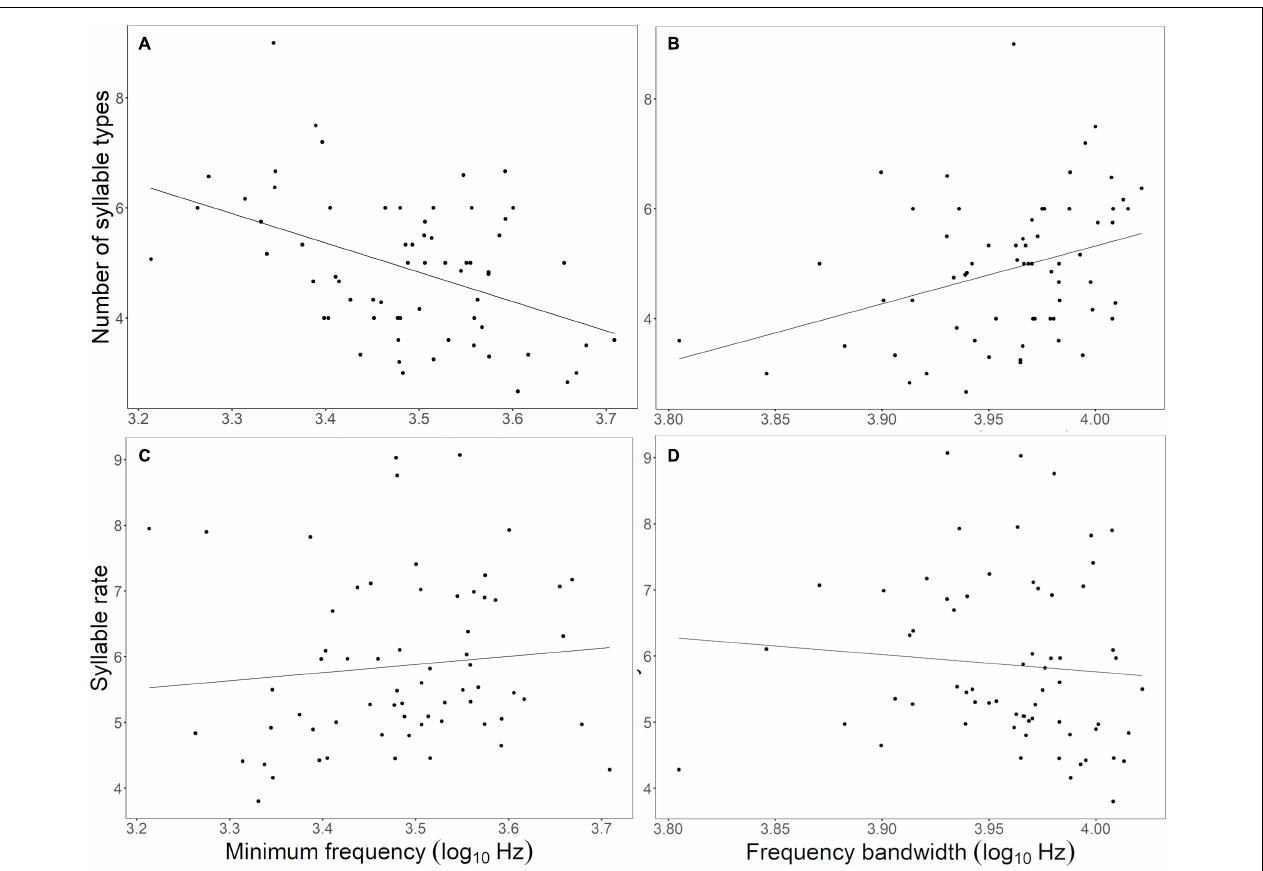
FIGURE 4 | Phenotypic restriction of the song syllable diversity (i.e., number of different syllable types) and syllable rate (i.e., syllables per second) by the increase of the minimum song frequency (A,B) and the decrease of the frequency bandwidth (C,D) . The black lines represent the fitted linear model for significant